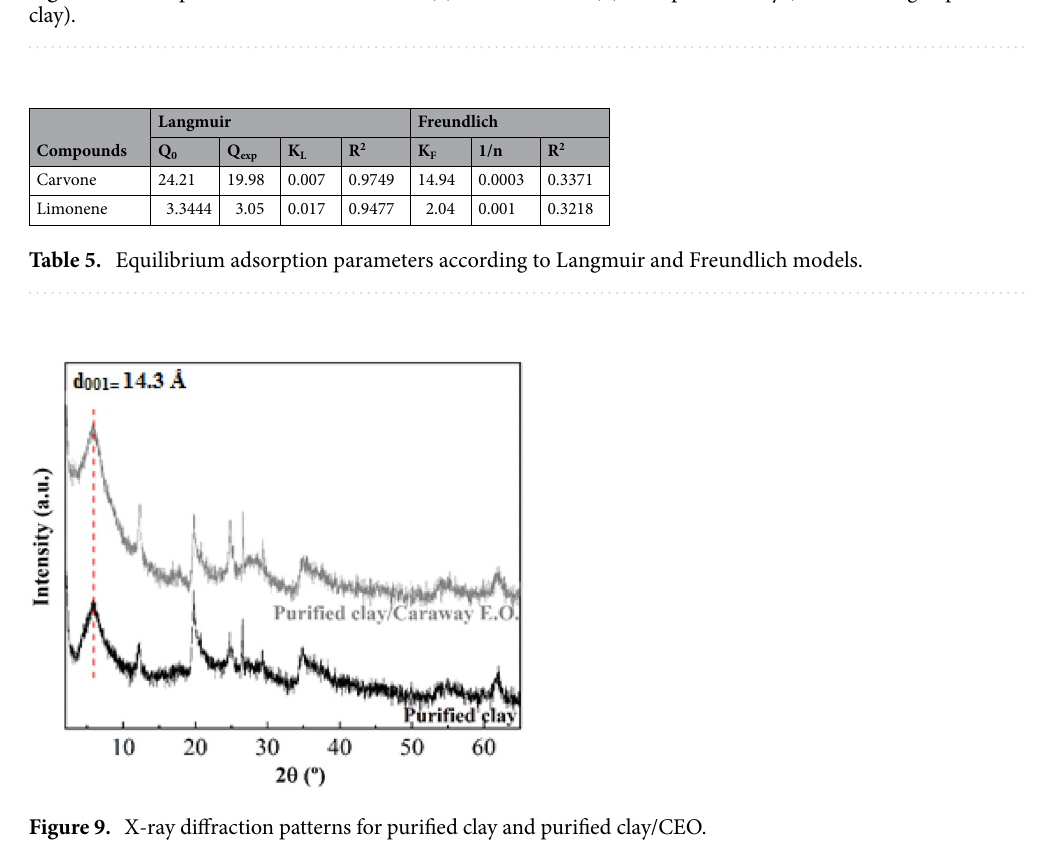
Figure 8. Adsorption isotherms of Carvone ( a ) and Limonene ( b ) onto purified clay (5 h and 0.03 g of purified clay).